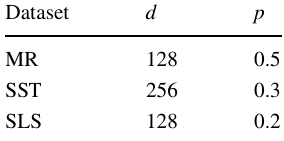
hyperparameters for each dataset